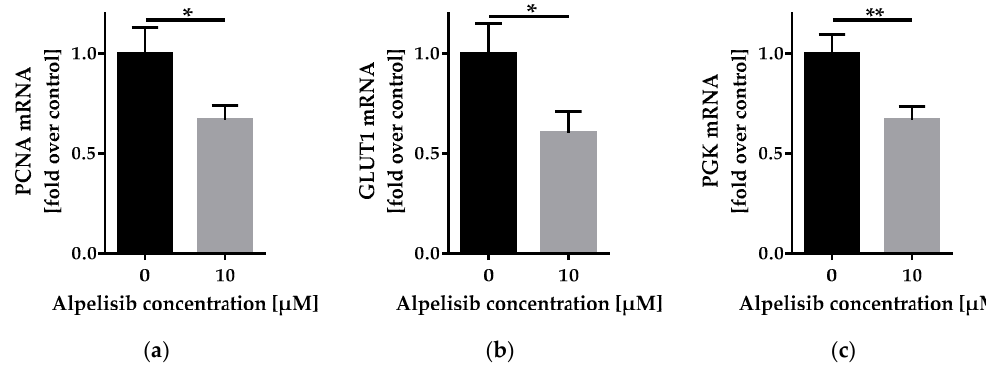
Figure 5. RT-qPCR of cell cycle and glucose metabolism genes from LipPD1 cells after 24 h treatment with 10 µM alpelisib: mRNA expression of ( a ) PCNA , ( b ) GLUT1, and ( c ) PGK was downregulated in 10 µM alpelisib-treated cells. Fold over control, values were normalized to the housekeeper gene TBP , n = 6, * p ≤ 0.05, ** p ≤ 0.01.